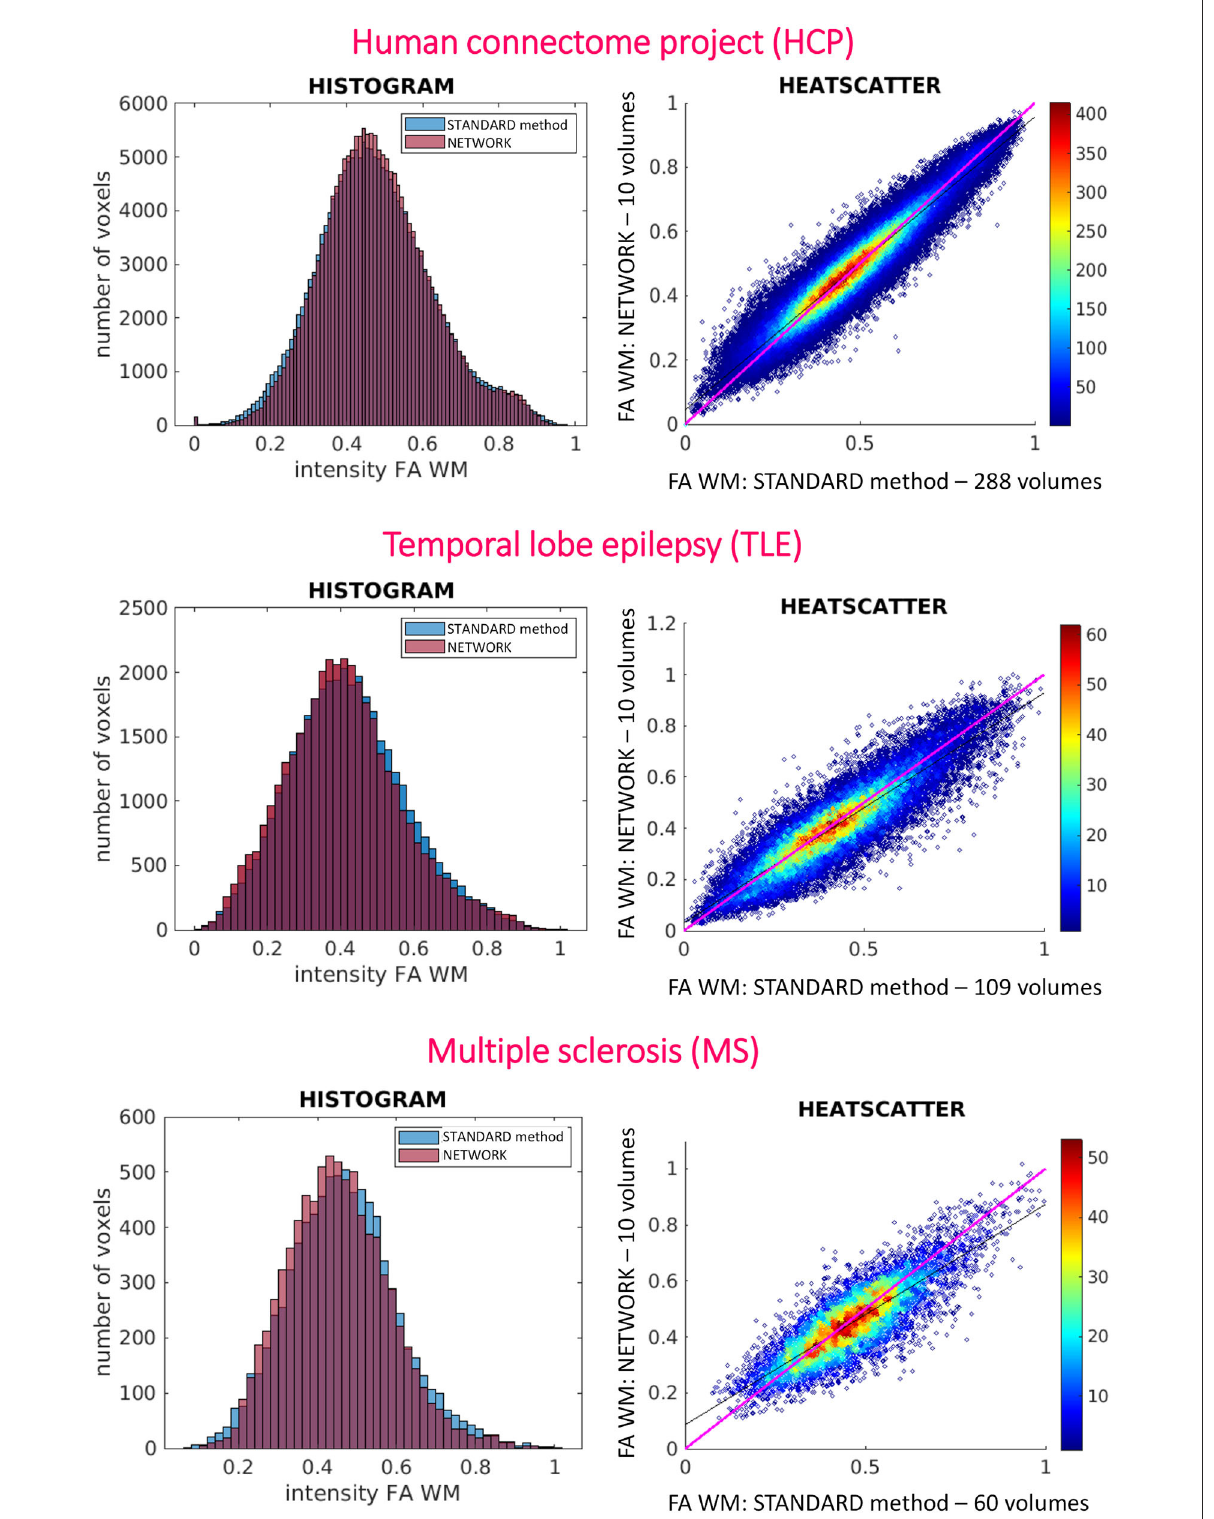
FIGURE7 On the left are reported the histograms of fractional anisotropy (FA) distributions in white matter (WM) for the three used datasets [Human Connectome Project (HCP), temporal lobe epilepsy (TLE), and multiple sclerosis (MS)]. On the right are reported the heatscatter plots showing pairwise voxel correspondence between FA maps calculated in different ways (STANDARD method and NETWORK); the bisector of the scatterplots, for reference, is shown in